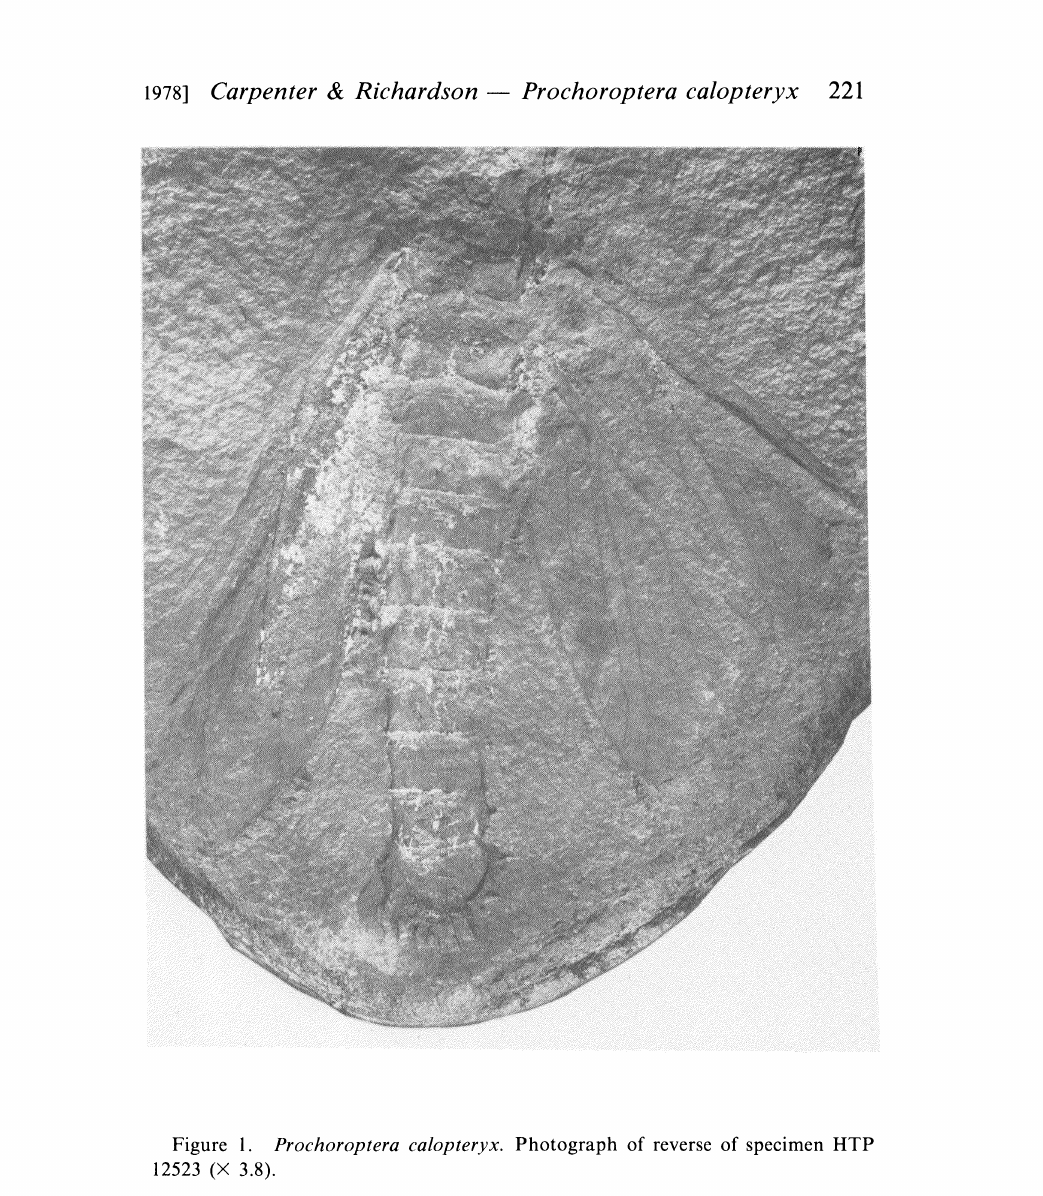
Figure I. Prochoroptera calopteryx. Photograph of reverse of specimen HTP 12523 (